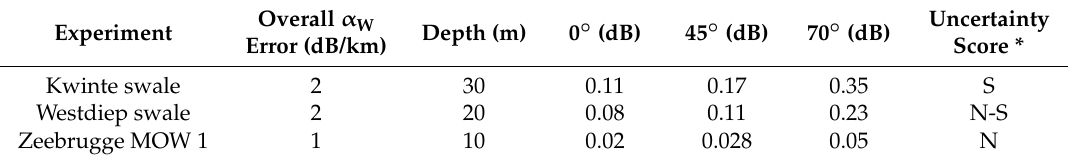
Table 7. Table reporting the estimated uncertainty introduced by the seawater absorption coefficient ( sensu [40,41]) for each experiment and for nadir (0 ◦ ), oblique (45 ◦ ) and grazing (70 ◦ ) angles. This ( sensu [40,41]) for each experiment and for nadir (0°), oblique (45°) and grazing (70°) angles. This uncertainty estimate was accounted for during acquisition. uncertainty estimate was accounted for during acquisition.